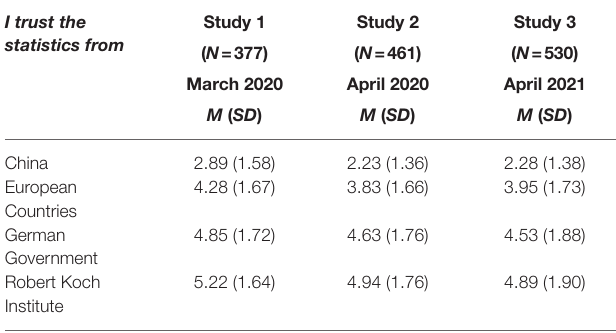
TABLE 1 | Participants’ trust in official information in Study 1, Study 2, and Study